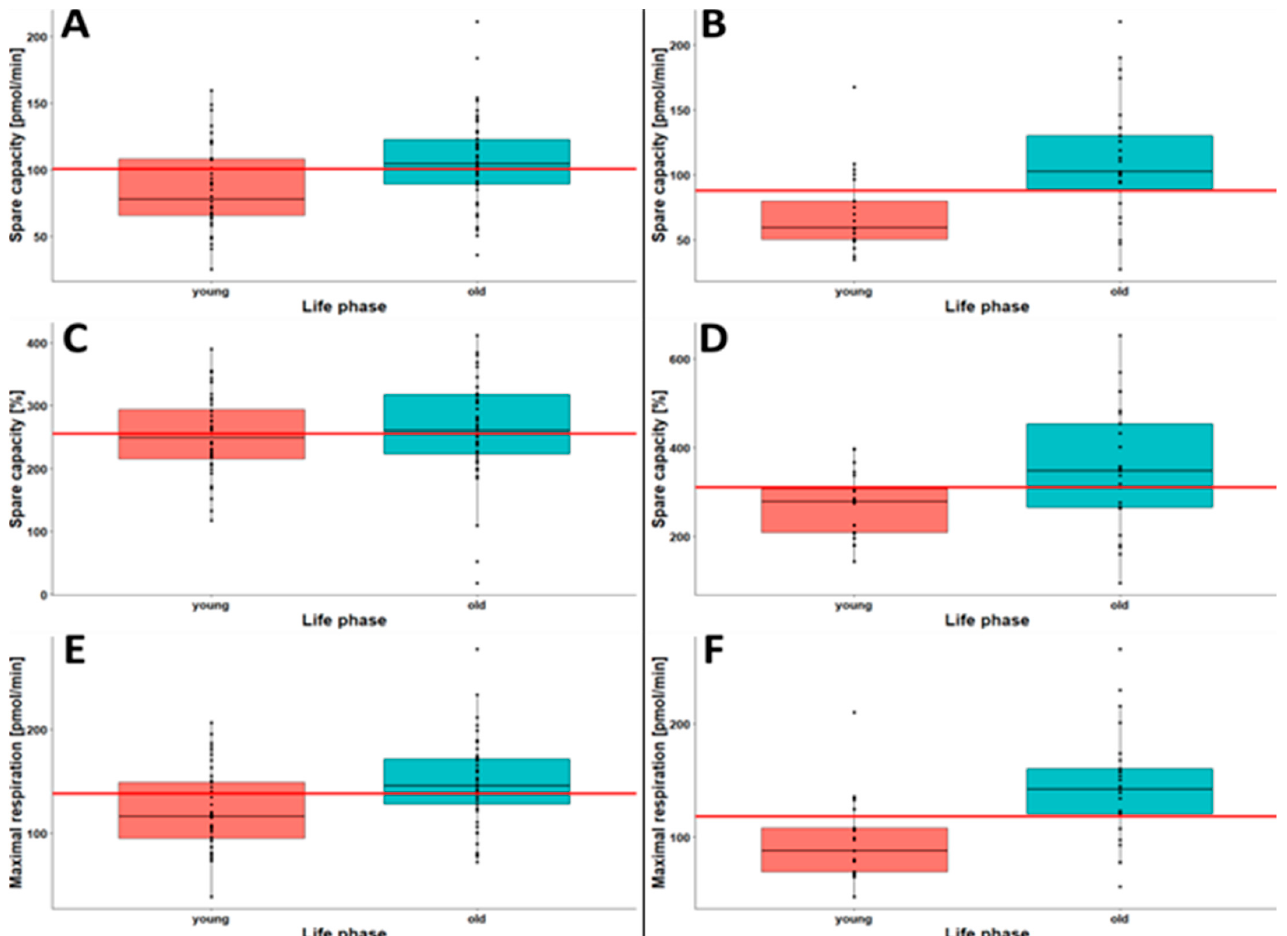
Figure 4. Boxplots of spare capacity (pmol/min) ( A , B ), spare capacity (%) ( C , D ) and maximal respiration (pmol/min) ( E , F ) in young and old persons in Opti-isolated PBMCs ( A , C , E ; young n = 40, old n = 49) and Robo-isolated PBMCs ( B , D , F ; young n = 21, old n = 25). The red horizontal line indicates the median of all life phases.